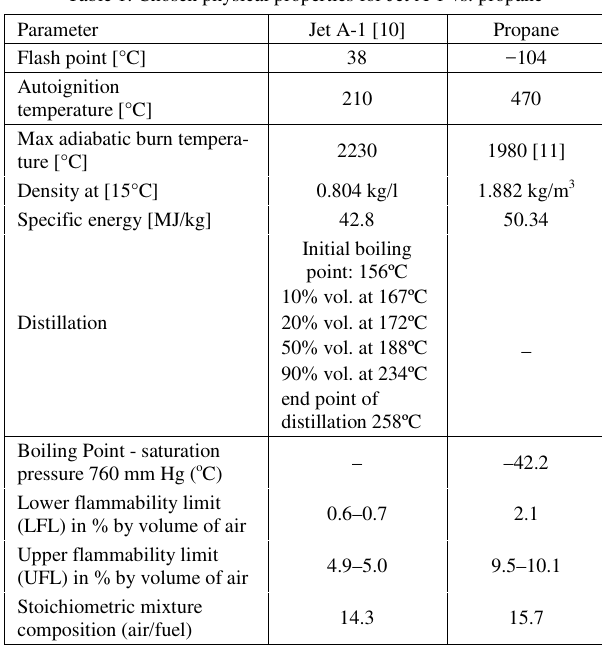
Table 1. Chosen physical properties for Jet A-1 vs. propane